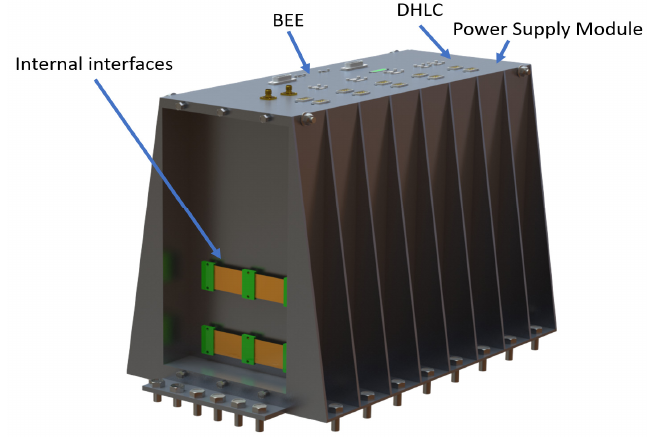
Figure 4. Baseline design for the ICU physical assembly (rendered image).